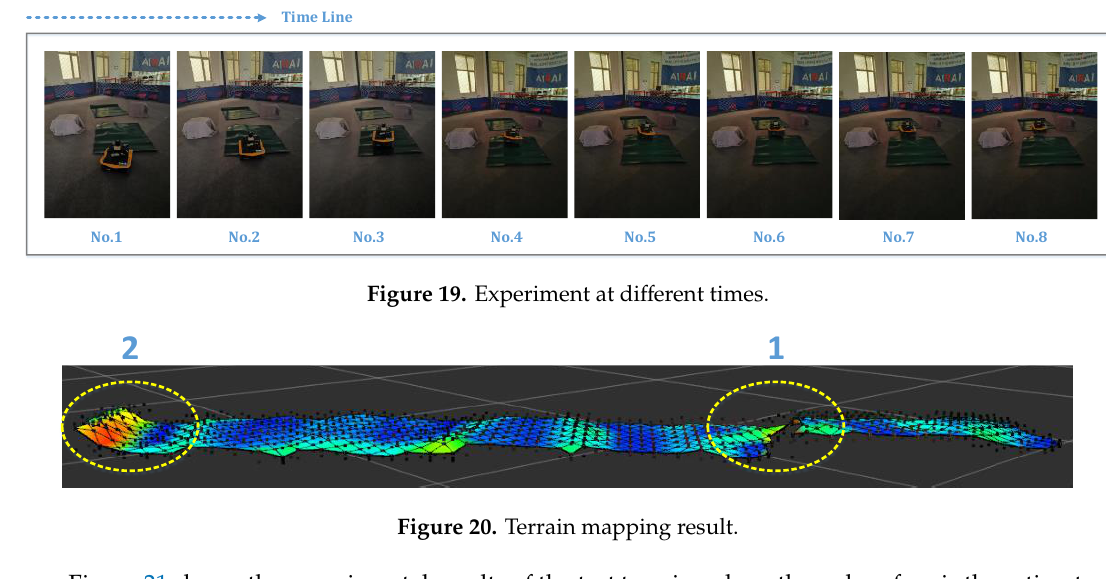
Figure 20. Terrain mapping result.